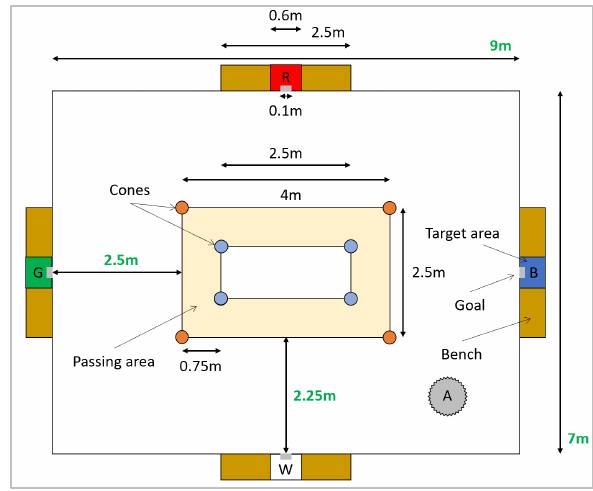
Figure 1. Overview of the set-up. Distance between the center square and the benches were adapted to fit the available space. Dimensions which differ from the original LSPT are in Green. ‘R’, ‘G’, ‘B’ and ‘W’ mark the red, green, blue and white targets, respectively. ‘A’ indicates a support column (adapted from Ali et al., 2008).